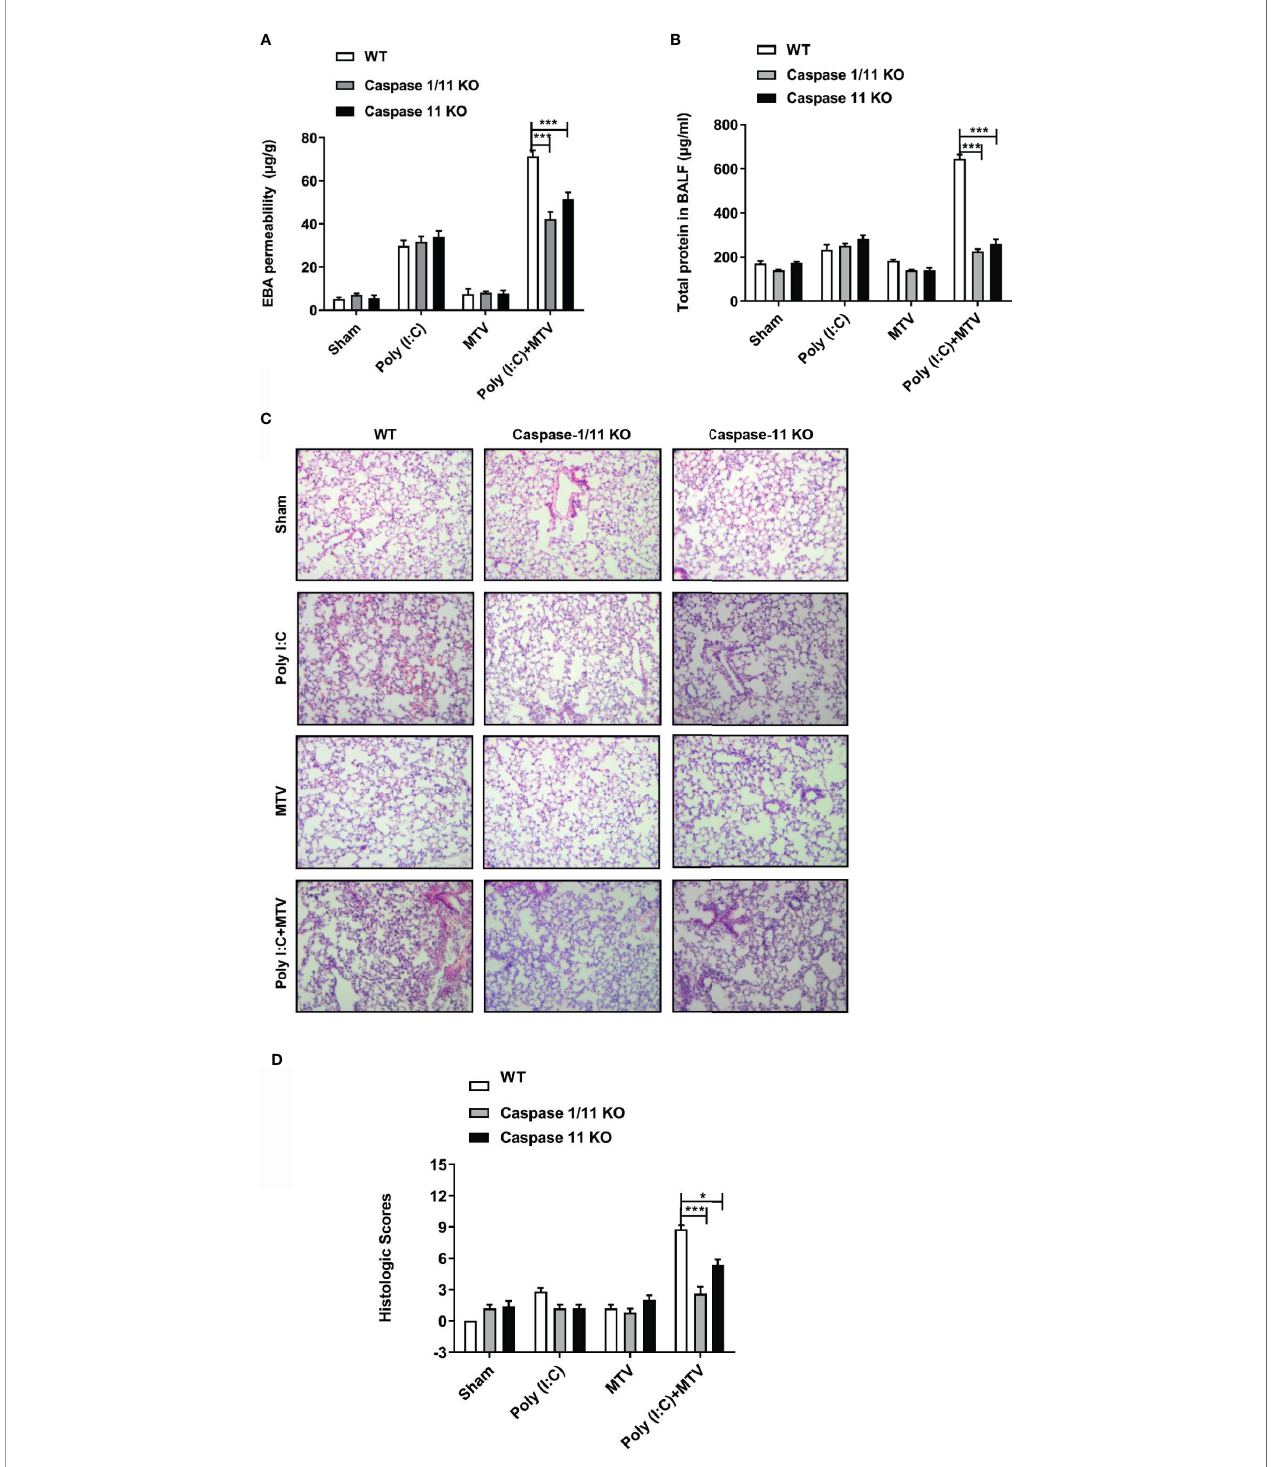
FIGURE 2 | Caspase-1 and caspase-11 prevented Poly(I:C)-MTV induced lung injury. Wildtype (WT), Caspase-1/11 null and Caspase-11 null mice (Caspase 1/11 KO and Caspase 11 KO) were treated with four groups as indicated. EBA permeability (n=5) (A) , total protein concentration in BALF (n=6 for WT mice, n=12 for caspase- 1/11 and caspase-11 KO mice) (B) , H&E histology (n=5) (C) of the lung cross section from WT, caspase-1/11 KO, caspase-11 KO mice (Scale bars: 50 m m) and total histopathologic scores of lung injury (D) were evaluated by two different authors calculated for each animal. Results are shown as means ± SEM and compared by one-way ANOVA and Student-Newman-Keuls test. * p < 0.05, *** p <